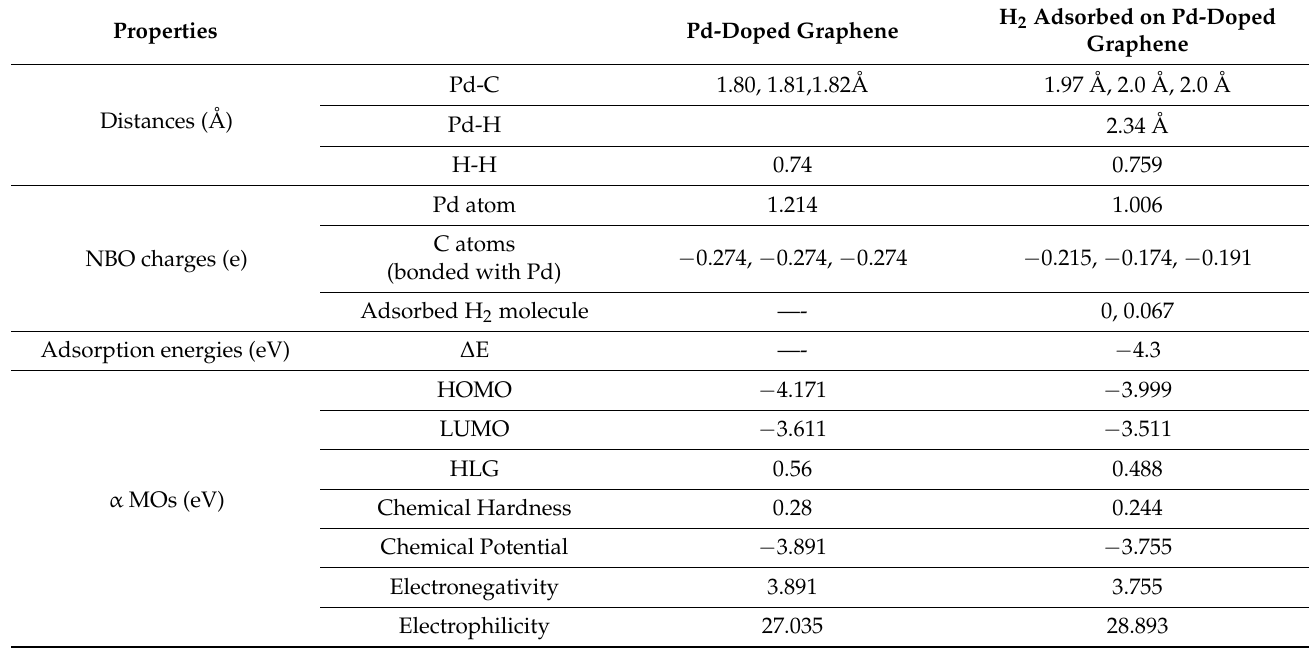
Table 1. Properties of the Pd-doped graphene cluster before and after H 2 interaction.